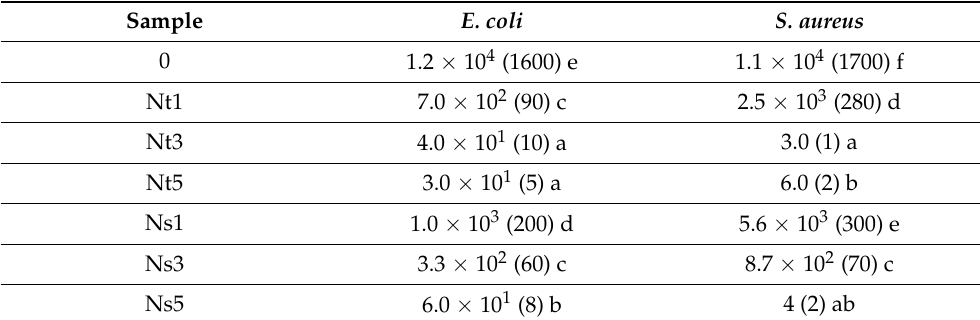
Table 2. Number of viable bacterial cells after incubation CFU/cm 2 (mean ± standard deviation in brackets). Statistically significant differences in the columns are marked with different letters for p < 0.05. Abbreviations: as in Figure